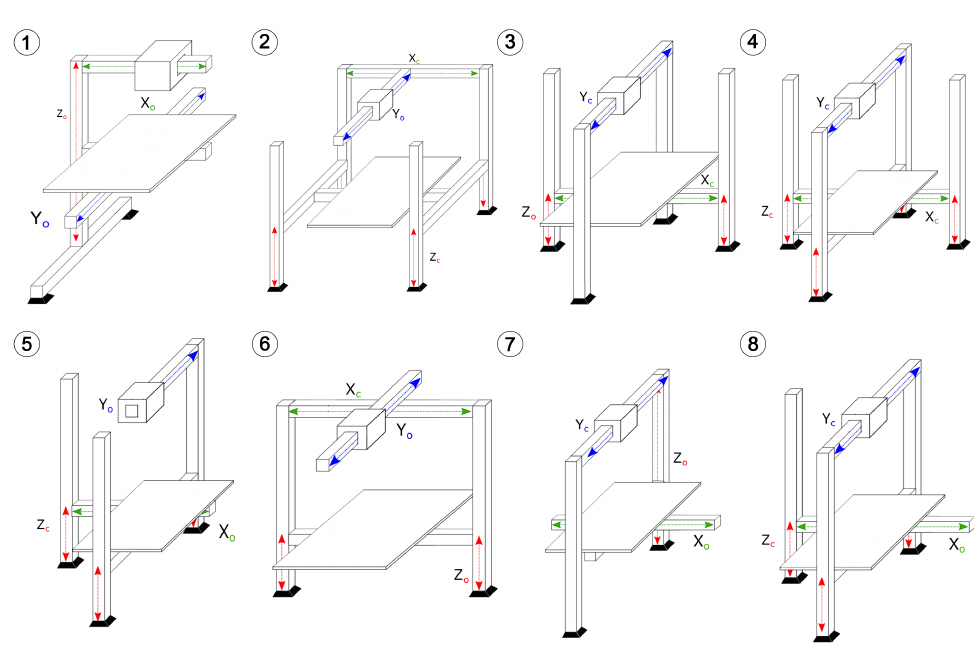
Figure A8. Fixed axes X B , Y H , Z H and actuated axes X H , Y B , Z B . Existing design is 7.